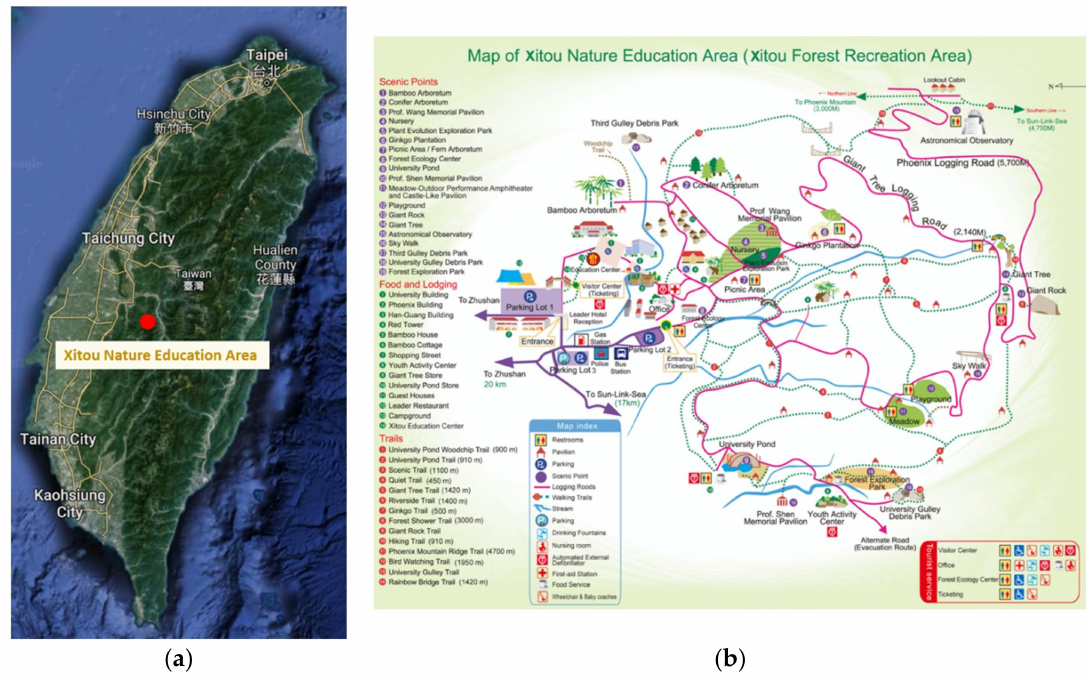
Figure 2. Xitou Nature Education Area (XNEA) location and site map (source: Google Earth ( a ); About the Nature Education Area ( b , [45]).